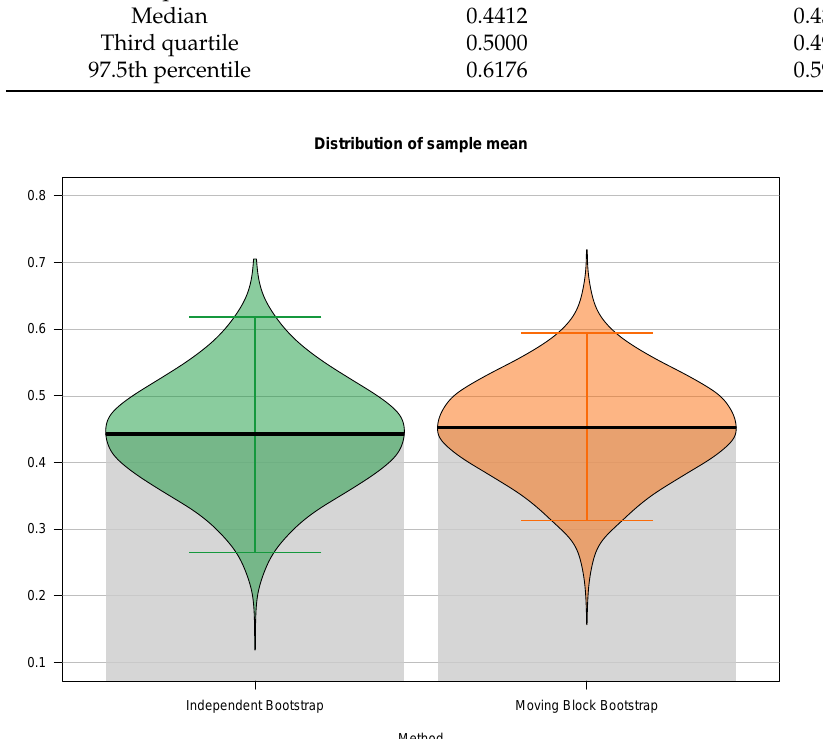
Figure 1. Empirical distributions of the sample mean based on the independent bootstrap (green—incorrect approach) against moving block bootstrap (orange—proper approach) for the correct/incorrect answers by a subject from the Programme for International Student Assessment (PISA) 2012—U.S. Math